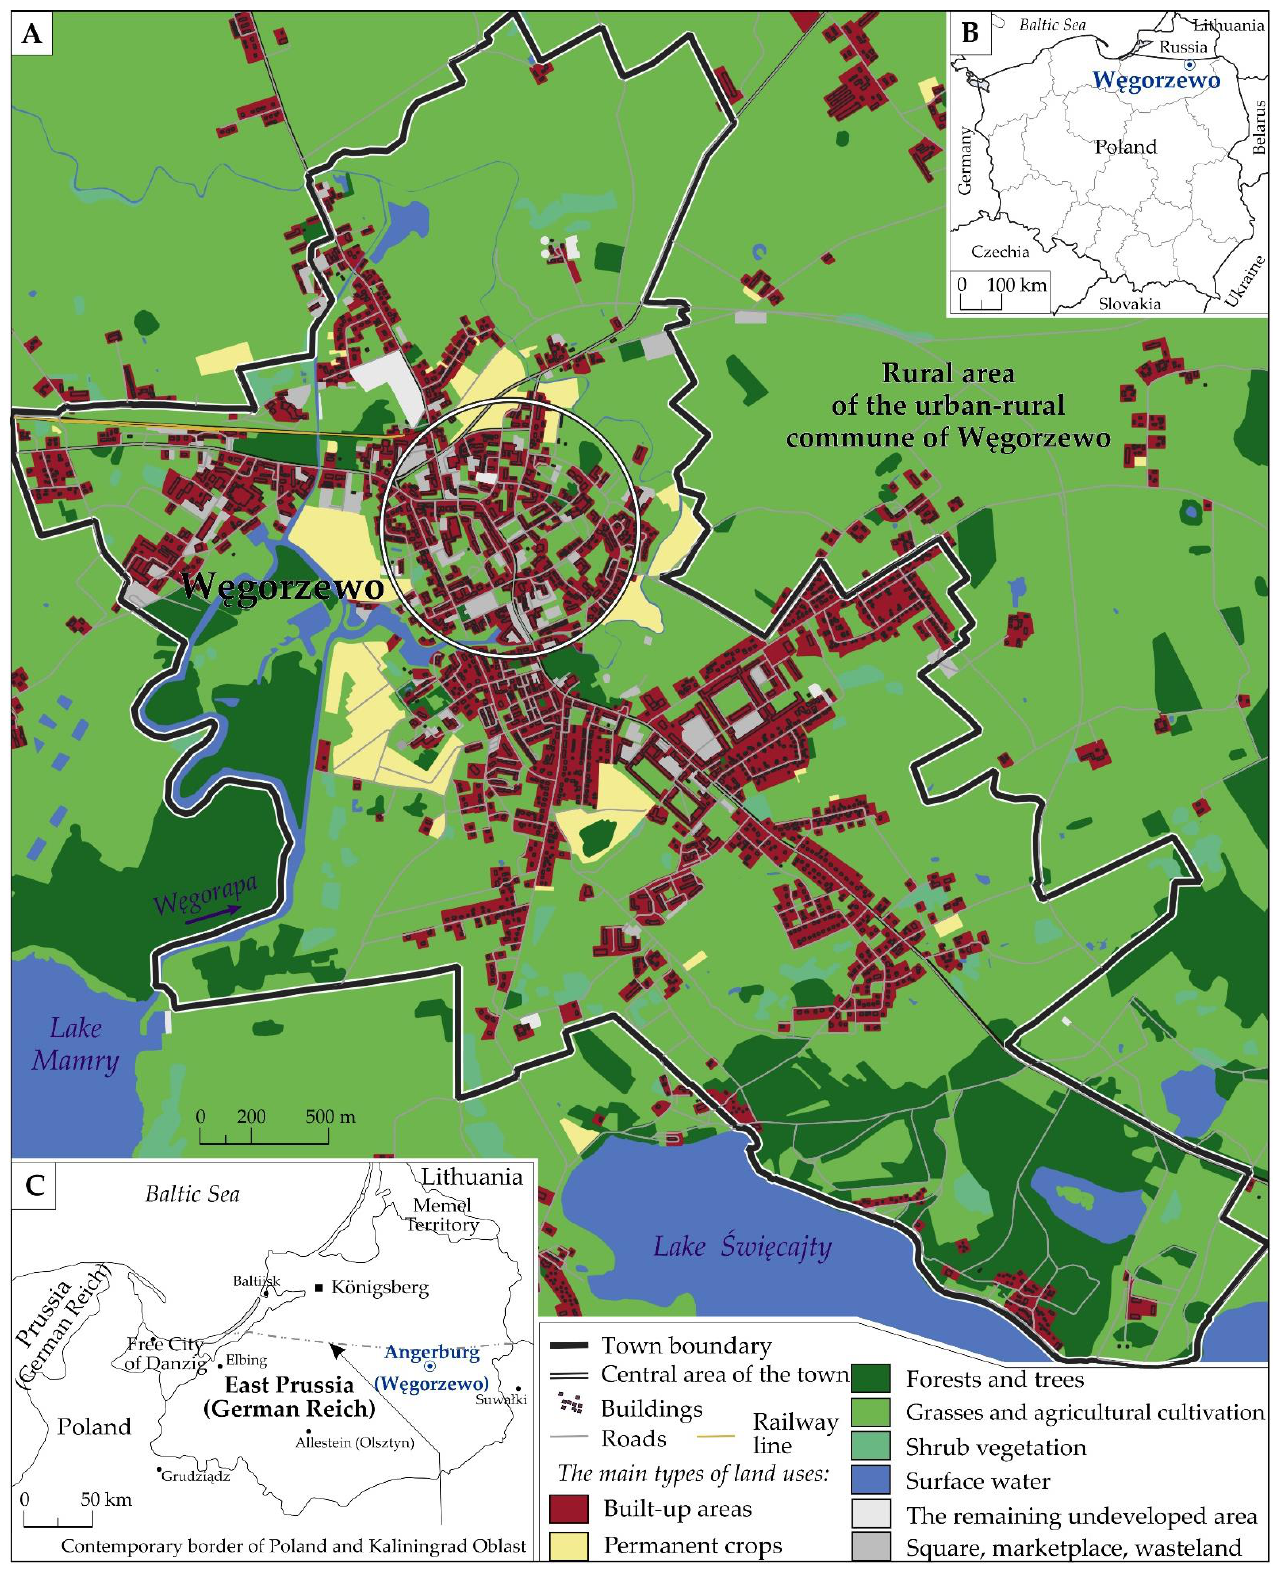
Figure 1. ( A ) Land use in Węgorzewo in 2020; ( B ) the location of Węgorzewo within present administrative and political borders; and ( C ) the location of Węgorzewo within historical and political borders (1939). Source: ( A ), ( B ) and ( C ) own study; ( A ) using the Topographic Objects Database BDOT [68].